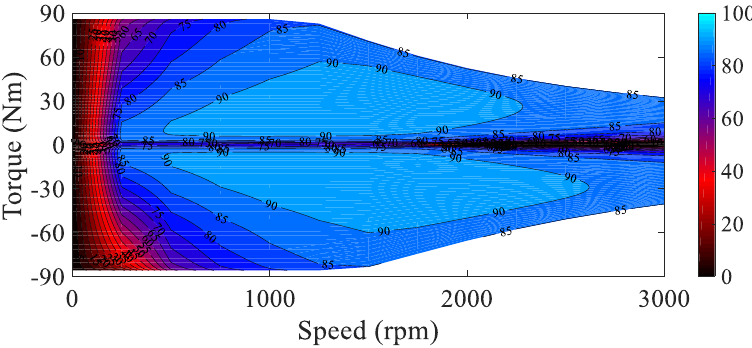
Figure 20. Efficiency (%) map of the Model-III.